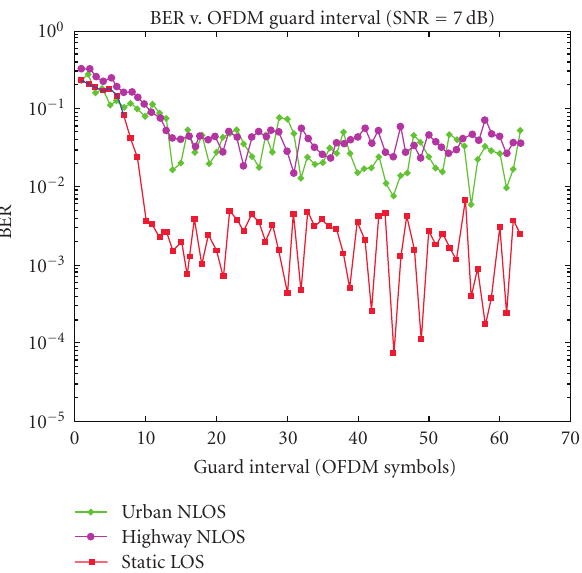
Figure 8: BER simulation of BPSK 1/2 rate with three channel